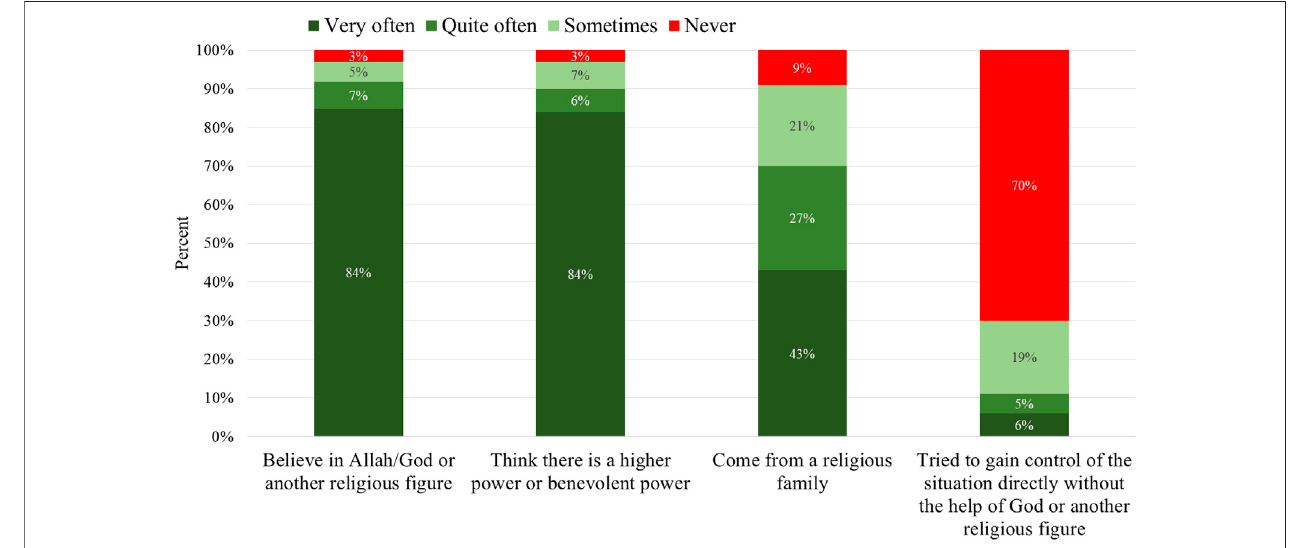
FIGURE 3 | Religious and spiritual background.